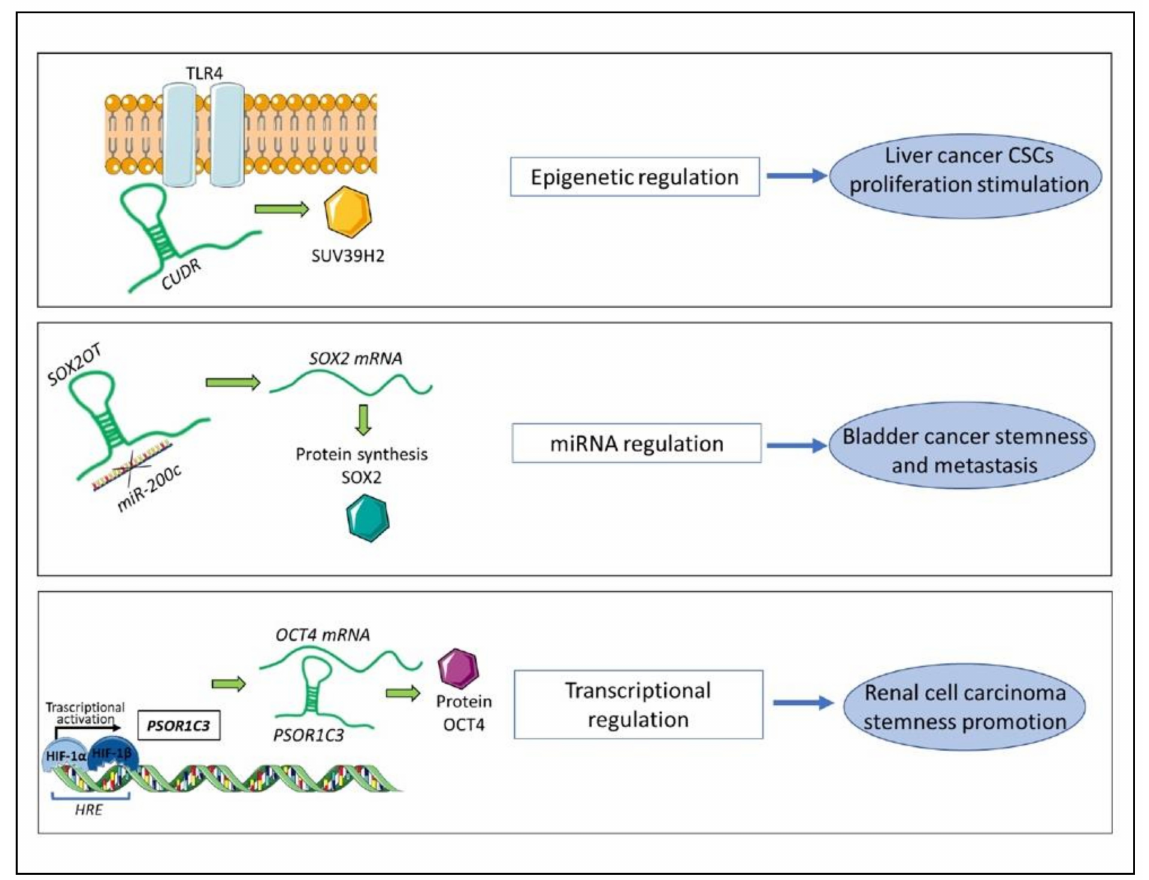
Figure 3. Long noncoding RNAs (LncRNAs) contribute to CSC features via the regulation of different cellular mechanisms. The three main mechanisms of actions of lncRNAs in CSCs regulation: Top panel: the lncRNA CUDR interacts with TLR4, thereby enhancing its function and promoting the activity of SUV39H2. SUV39H2 is involved in epigenetic regulation that stimulates liver cancer CSC proliferation. Centre panel: the lncRNA SOX2OT sequesters miR-200c , thereby inhibiting its function of targeting SOX2 mRNA. Therefore, SOX2OT indirectly promotes translation of the stemness factor SOX2 in bladder cancer. Lower panel: the genetic locus of PSORC1C3 contains an HRE responding to hypoxia-inducible factor (HIF) transcription factors. HIF triggers a CSC phenotype via PSOR1C3 which interacts with OCT4 mRNA, thereby stabilising it and promoting protein production and function in renal cell carcinoma cells. CSCs: cancer stem cells; HRE: hypoxia response